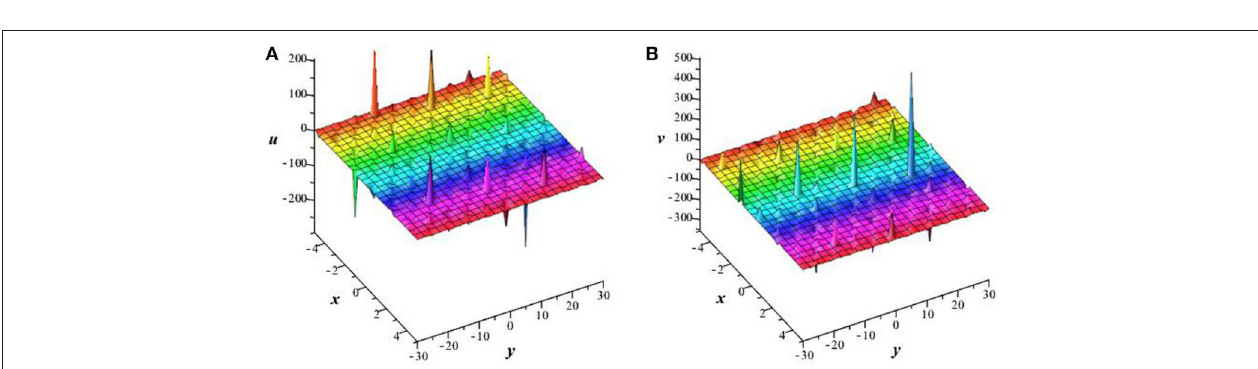
FIGURE 1 | Plot of invariant solution (25) with δ 1 ( t ) view of the solution v .